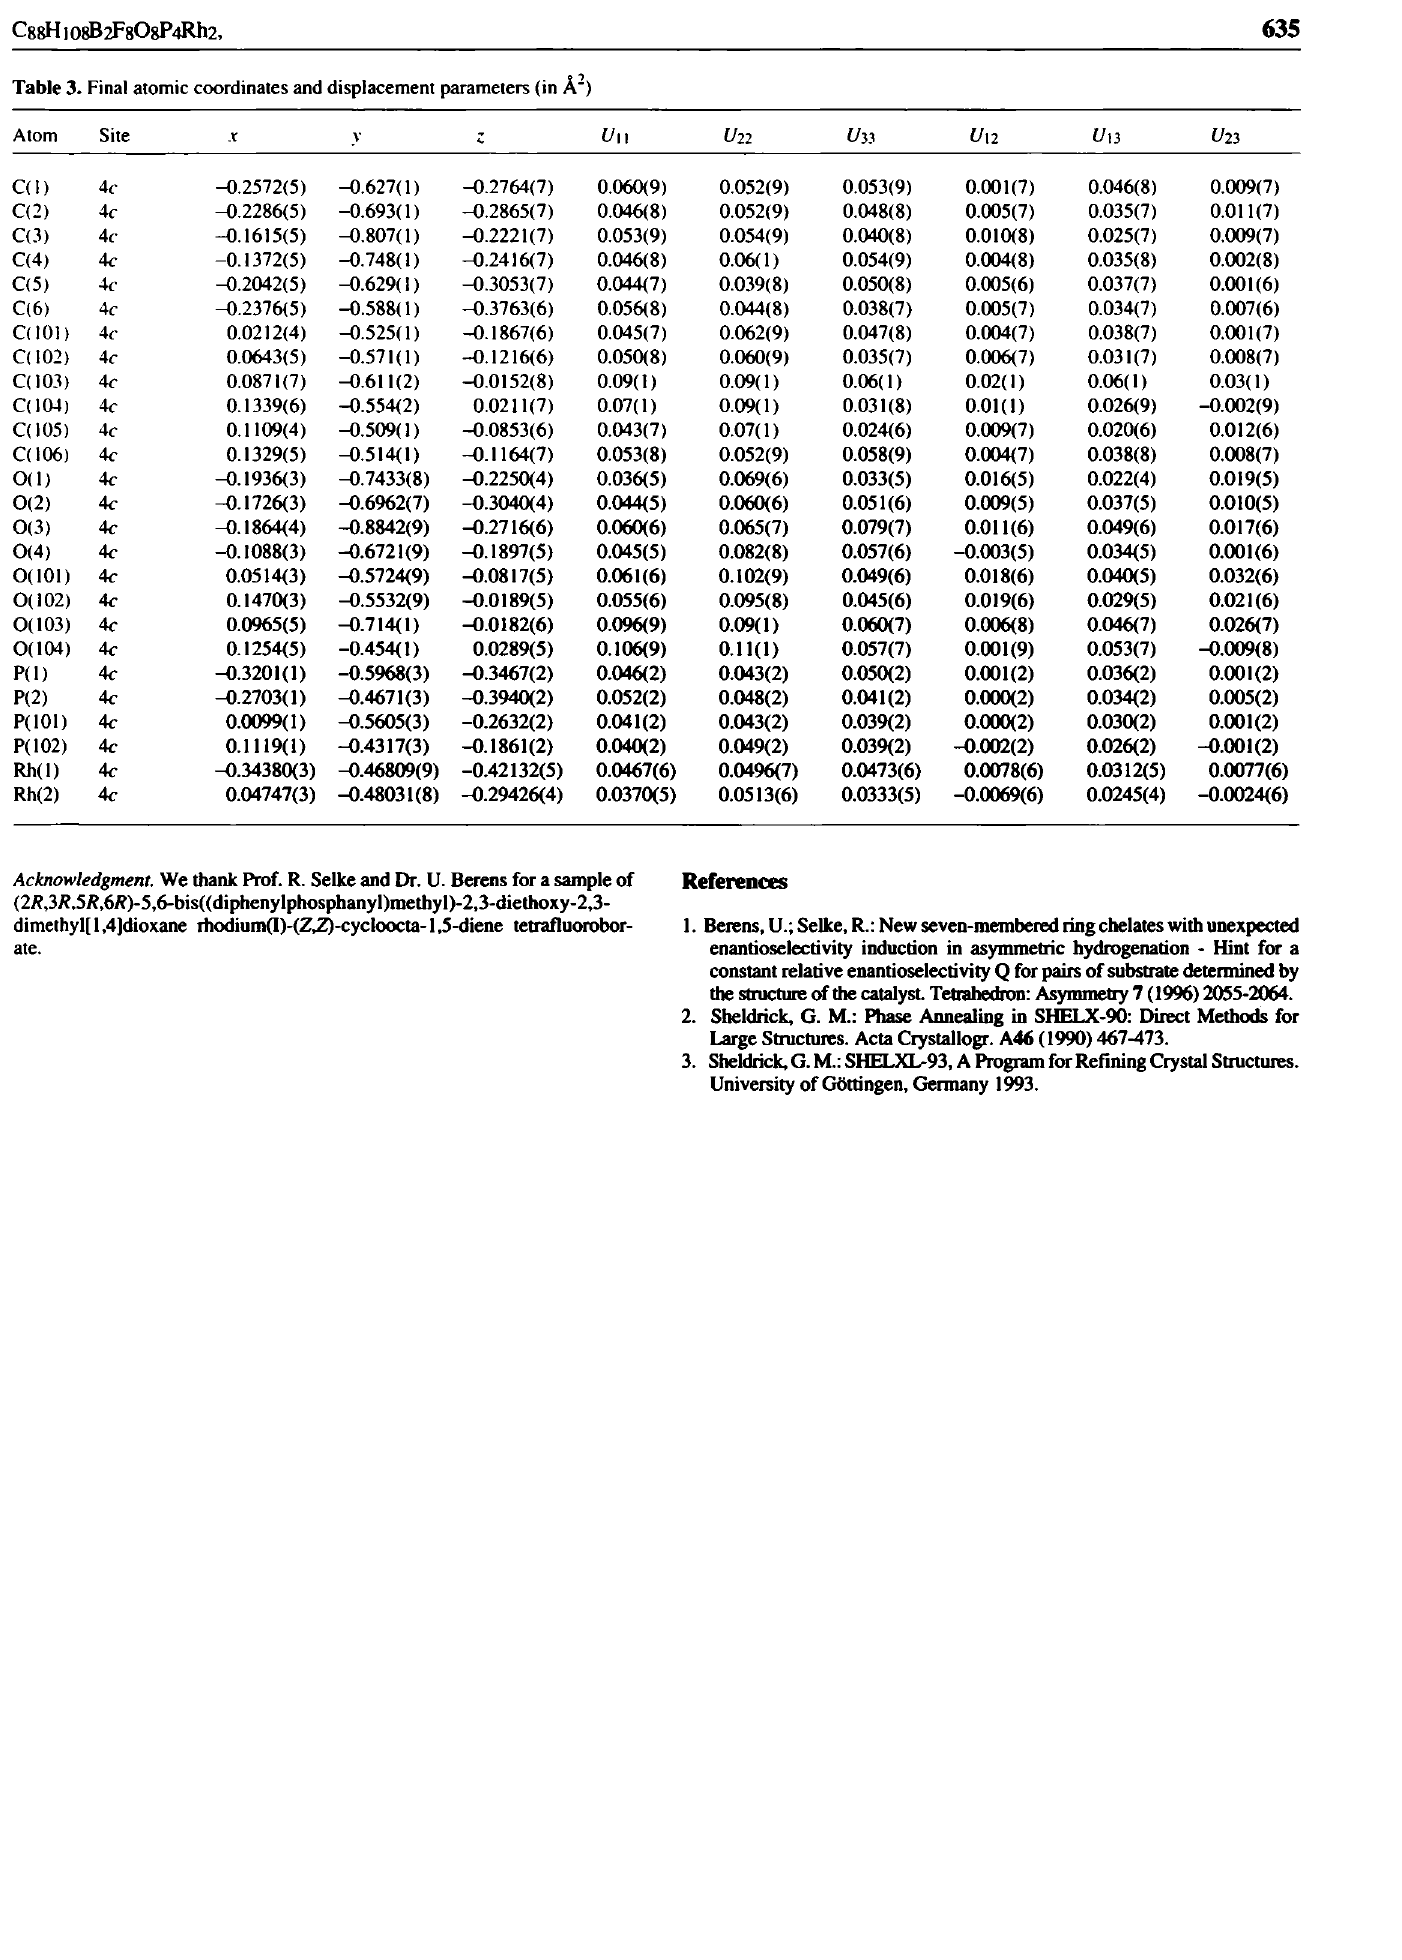
Table 3. Final atomic coordinates and displacement parameters (in